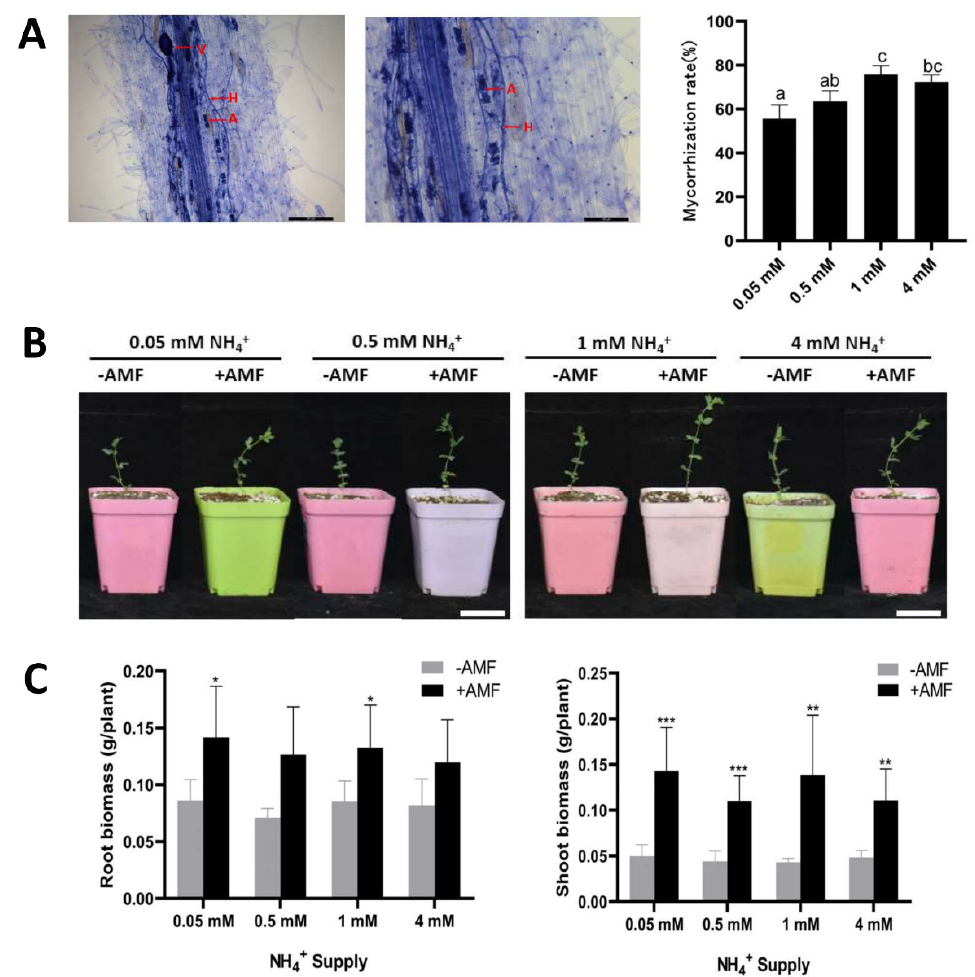
Figure 4. Effects of AMF colonisation on the growth of Lotus japonicus under different ammonium concentrations. ( A ) Trypan blue staining and colonisation rate statistics. H, Hyphae; V, vesicle; A, arbuscule ( B ) Phenotypes of wild-type plants under different ammonium ion concentrations. ( C ) Biomasses of aboveground and underground parts of plants under symbiotic and non-symbiotic conditions. Data are means ± standard error (SE; n ≥ 3 biological replicates; * p ≤ 0.05, ** p ≤ 0.01, *** p ≤ 0.001).